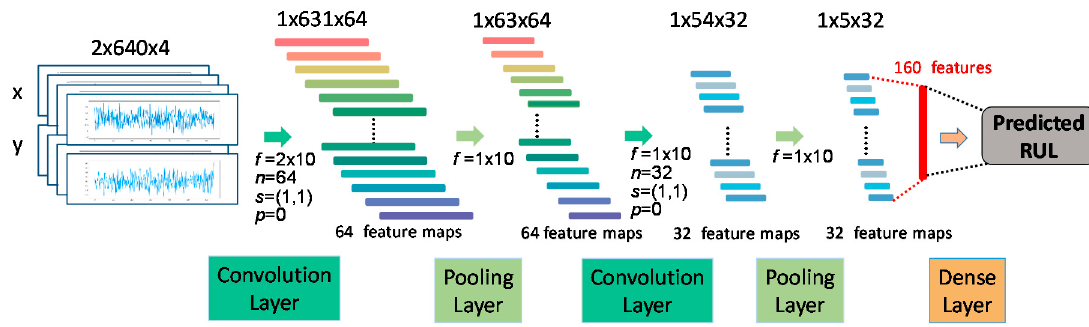
Figure 11. The TSMC-CNN with K channels ( K = 4).